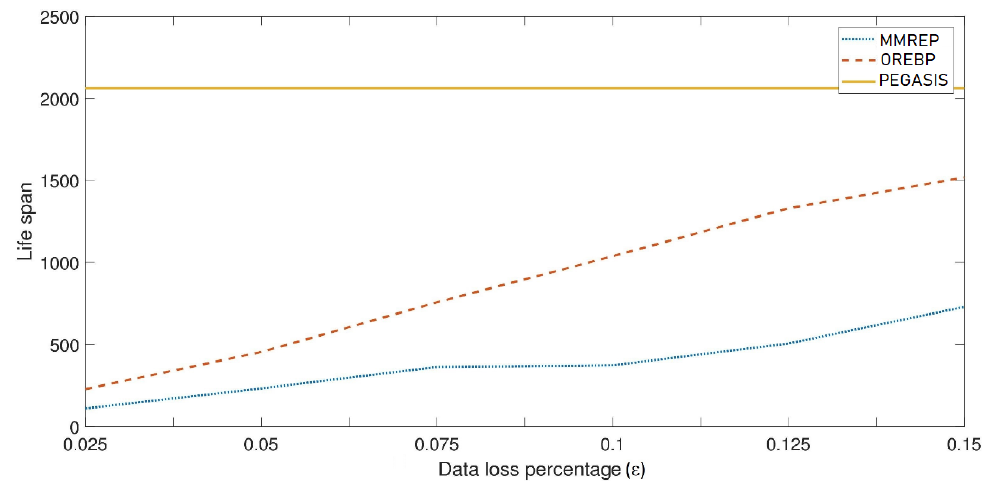
Figure 4. Life span with different data loss (𝜀) .